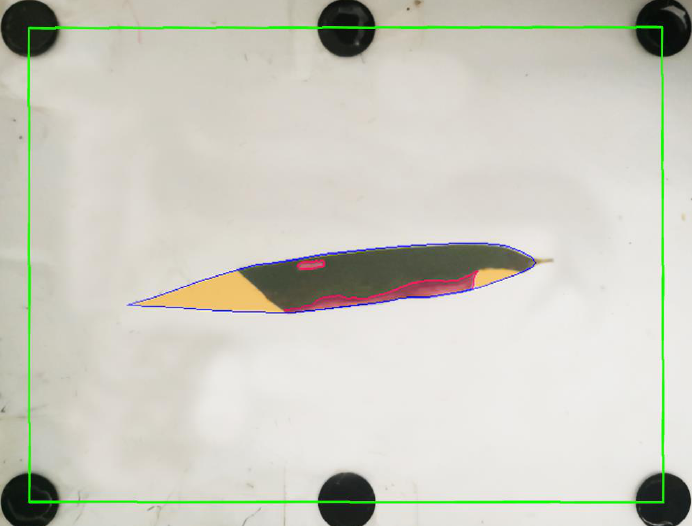
Figure 3. The example of a damaged leaf. The green line is the boundary of the reference box used to calculate areas of indentation and disease spots. Yellow color indicates indentation parts manually delineated, and red color denotes disease spots visually determined.